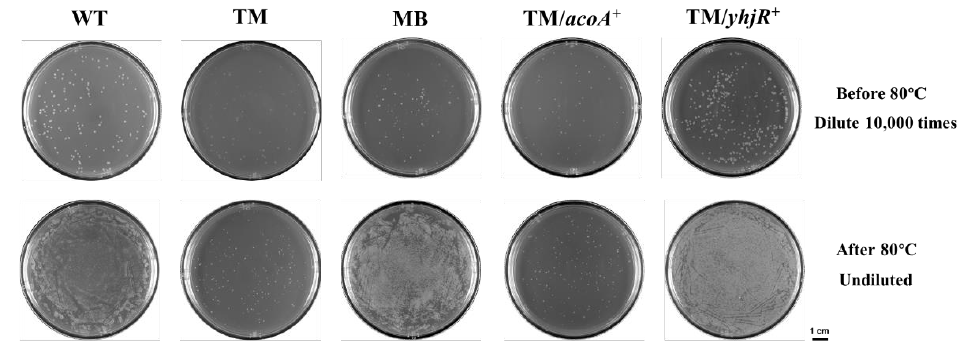
Figure 8. The sporulation ability in WT, TM, MB, TM/ acoA + , and TM/ yhjR + . The strains of WT, TM, MB, TM/ acoA + , and TM/ yhjR + were subjected to the high-temperature treatment at 80 ◦ C and observed for spores. The control samples were diluted (10,000 times) before high-temperature treatment for plating. The treatment samples were undiluted after high-temperature treatment, plated on LB agar plates and incubated for 12 h at 37 ◦ C. The images shown are the representatives of three independent experiments. The scale represents 1 cm.